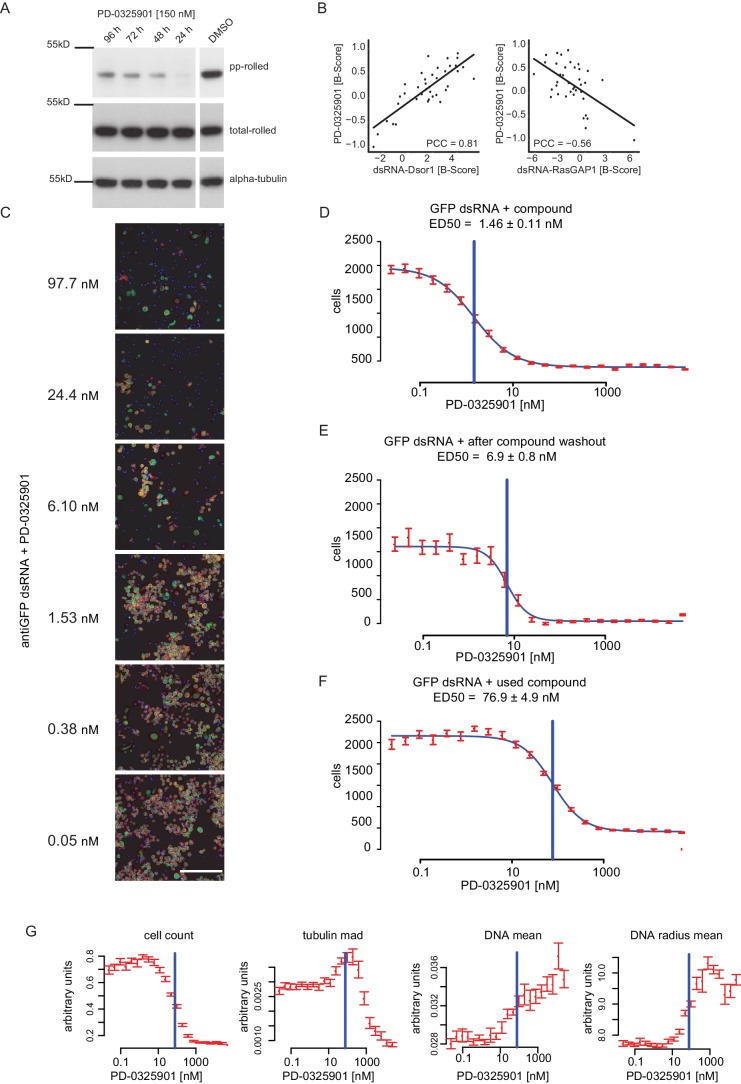
Dsor1 inhibiting effect of PD-0325901 shown by loss of rl phosphorylation, loss of viability and differential phenotypic responses.(A) S2 cells were treated for either 24 hr, 48 hr, 72 hr and 96 hr using 150 nM PD-0325901 in 0.5% DMSO. Samples were lysed and subjected to western blot analysis. The DMSO only control was treated the same way in the same experiment and blotted on the same membrane, however initially not right next to the other samples. Membranes were stripped and re-probed for total-rolled and α-tubulin after each development. (B) Correlation analysis of compound (MEKi) vs. RNAi perturbation of Dsor1. Data was taken from B-Score normalized genome wide chemo-genetic screens. Thirty-eight features were analysed between MEK inhibitor and anti-RLUC treated controls (MEKi) and either Dsor1 or RasGAP1 knockdown. Correlation of median feature vectors is given as Pearson correlation coefficient (PCC). (C) Image based illustration of the concentration depended decline in cellular fitness (Scale bar = 140 µm). (D) Dose-response curve under co-perturbation with a dsRNA against GFP (not expressed in these cells). (E) Dose-response curve of the same cells after the drug containing medium was washed out and cells were left to grow for another 72 hr. (F) Dose-response curve after treatment of freshly seeded cells with the remainder medium of the treated cells. A horizontal blue line demarks the ED50 as estimated by four-parameter logistic regression (blue curve fit). All values are mean ±s.e.m. (red, n = 32). (G) Dose-Response curves were measured using a fluorescent microcopy-based read-out. Cells were segmented and extracted features summarized per well. Multiple features show a distinctive reactivity towards chemical inhibition of Dsor1 and demonstrate the power of multi-parametric phenotyping for measuring cellular reactions to small molecule treatment. The blue line indicates the ED50 estimate in this experiment. Data were taken from the ‘used compound’ treatment (E).